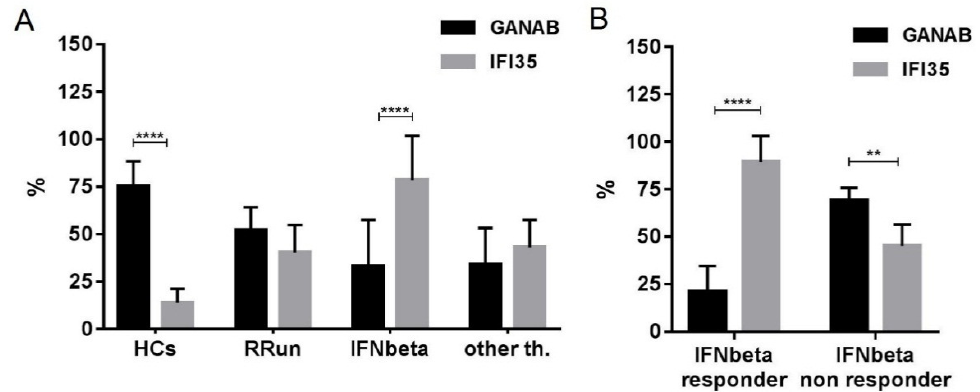
Figure 9. Expression of GANAB and IFI35 in all enrolled groups. Note statistically significant differences between the means of GANAB and IFI35 in ( A ) the HCs ( p < 0.0001) and IFNbeta-treated patients ( p < 0.0001), as well as in ( B ) the IFNbeta responder ( p < 0.0001) and IFNbeta non-responder ( p = 0.0022) patients. HCs, healthy controls; RRun, relapsing remitting untreated MS patients; IFNbeta responder, responder MS patients to IFNbeta-1a therapies; IFNbeta non responder, non responder MS patients to IFNbeta-1a therapies; other th., MS patients treated with other than interferon Symbol meaning: ** = p < 0.01; **** = p < 0.0001.